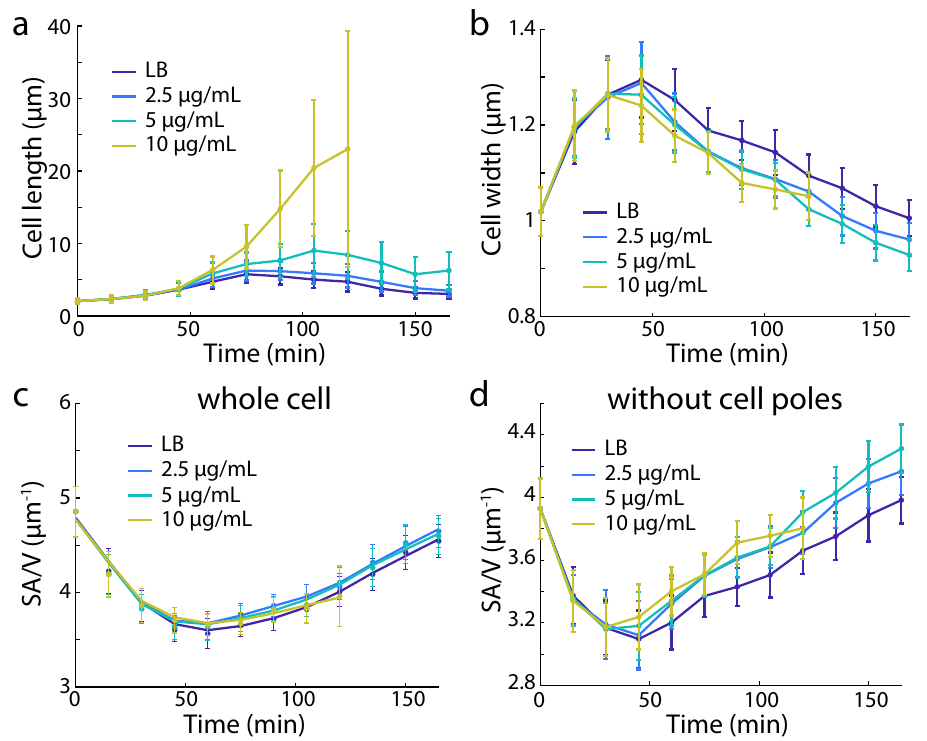
Fig. 4 SA/V dynamics are conserved across perturbations to cell morphology. Shape growth curves of E. coli MG1655 cells treated with sub-lethal concentrations of cephalexin. Cephalexin causes a dose-dependent increase in cell length ( a ), accompanied by decreased cell width ( b ). The increased lengths and decreased widths precisely maintain SA/V for all conditions ( c ), suggesting that SA/V is robust to perturbations in cellular dimensions. The SA/V of the cell body (excluding the poles) was not maintained under cephalexin treatment ( d ), highlighting the importance of cell poles in regulating SA/ V. Data points are mean ± S.D. with n > 200 cells. Source data are provided as a Source Data fi